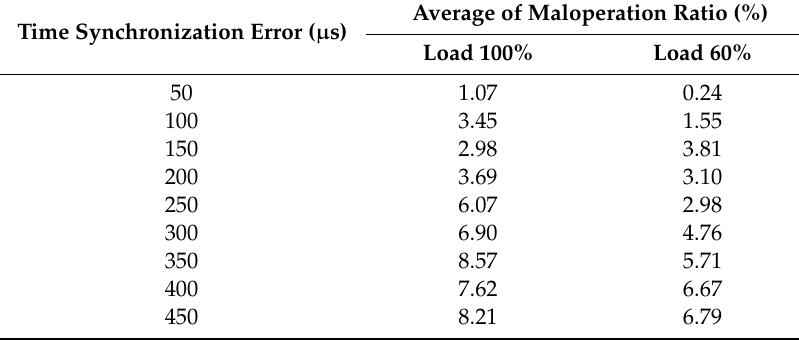
Figure 4. The result of performance of Substation-area Backup Protection (SBP) algorithm for Fault 2 case. Table 4. Average of maloperation ratio of SBP for Fault 1–3. Table 4. Average of maloperation ratio of SBP for Fault 1–3.